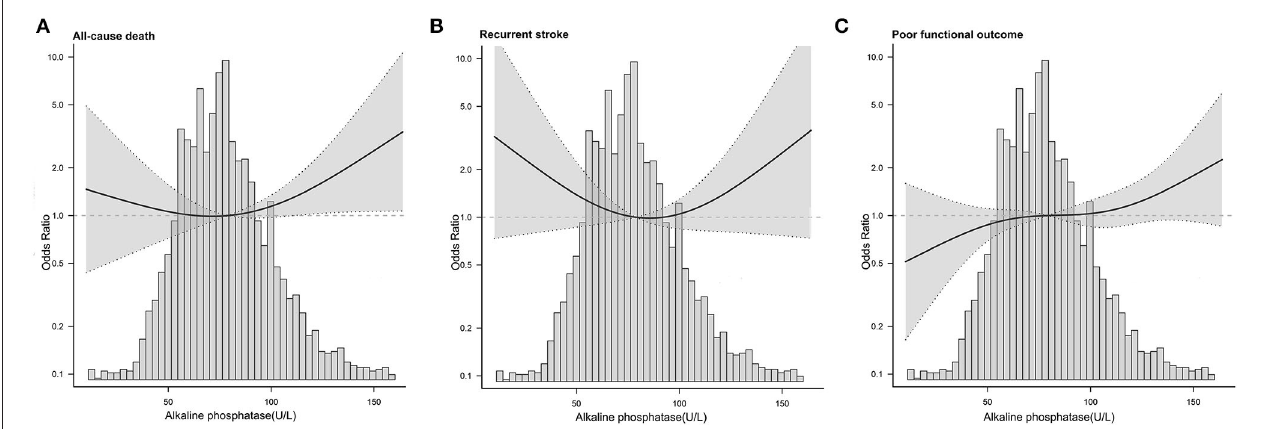
FIGURE 2 | Adjusted odds ratio of adverse outcome after acute stroke according to serum ALP levels on admission. (A) All-cause mortality. (B) Recurrent stroke. (C) Poor functional outcome.